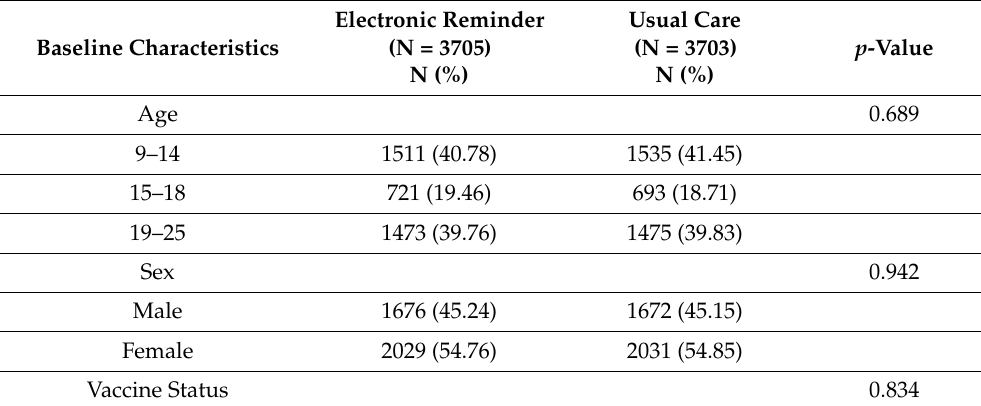
Table 2. Baseline Characteristics by randomized